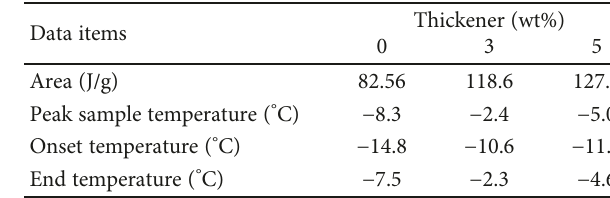
Table 3: DSC measurements.